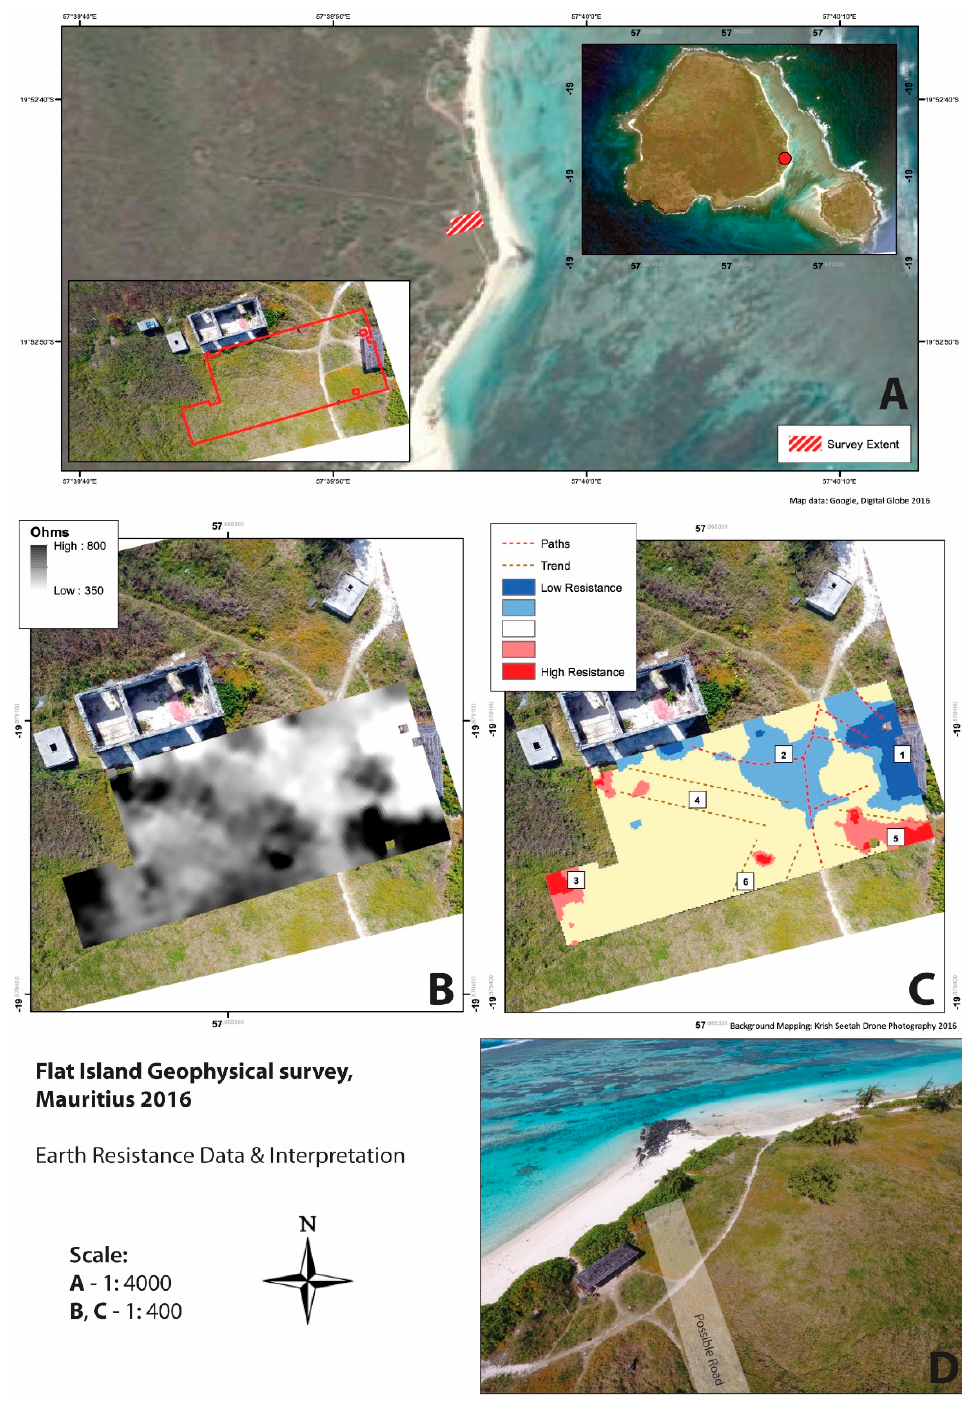
Figure 13. Geophysical survey near the baggage store: ( A ) survey extent; ( B ) earth resistance data; ( C ) interpretation of the data; ( D ) probable reconstruction of the original road.